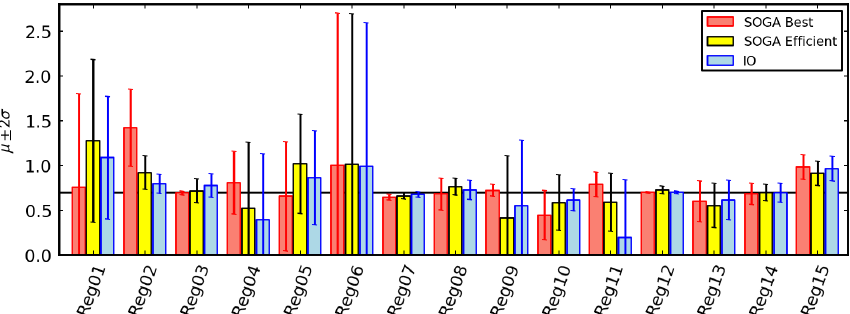
Figure 6. The figure shows the posterior weights for the emissions from the 15 regions for the SOGA Best, SOGA Efficient, and IO networks shown in Fig. 5. The posterior weights are presented as µ ± 2 σ , which excludes off-diagonal covariance contributions that are important for some regions. The target value of 0.7 is shown by the horizontal black